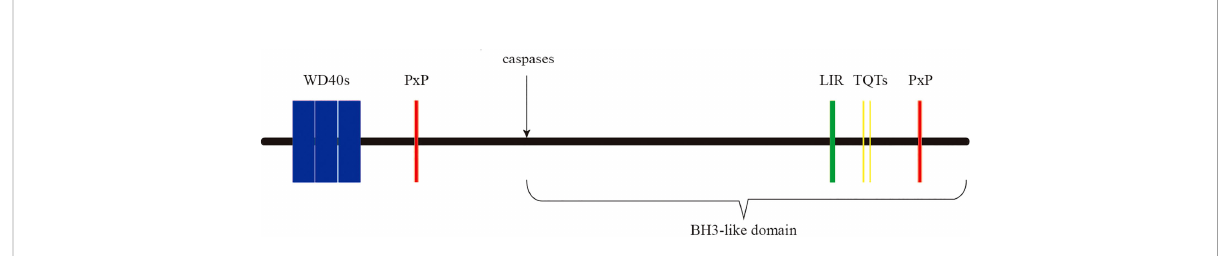
FIGURE 1 The domains and motifs of AMBRA1 protein. AMBRA1 contains WD40 domain (aa 1 – 175) and three kinds of motifs-two PxP motifs (aa 275 – 281 and 1206 – 1212), two TQT motifs (aa 1104 – 1106 and 1116 – 1118), and an LIR motif (aa 1043 – 1052). At the D482 site, AMBRA1 is cleaved by caspases.